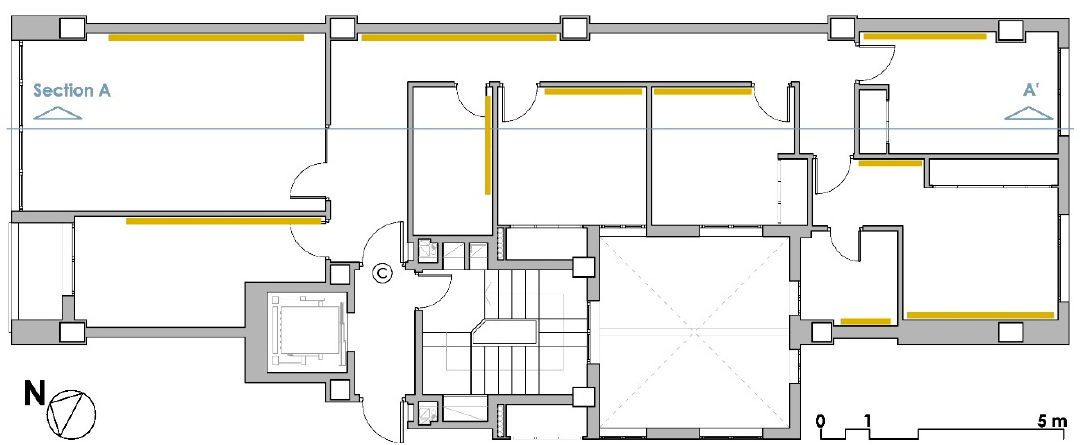
Figure 7. The northeast view of the building.